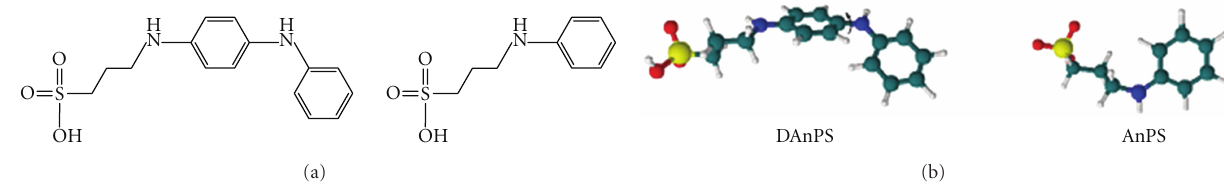
Figure 1: (a) The chemical structures and (b) the optimized structural geometry of the aniline derivatives, DAnPS and